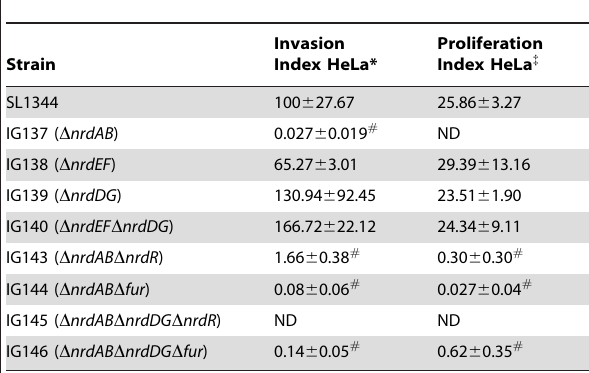
Table 1. Invasion and proliferation indexes of wild-type and mutant strains infecting HeLa epithelial cell